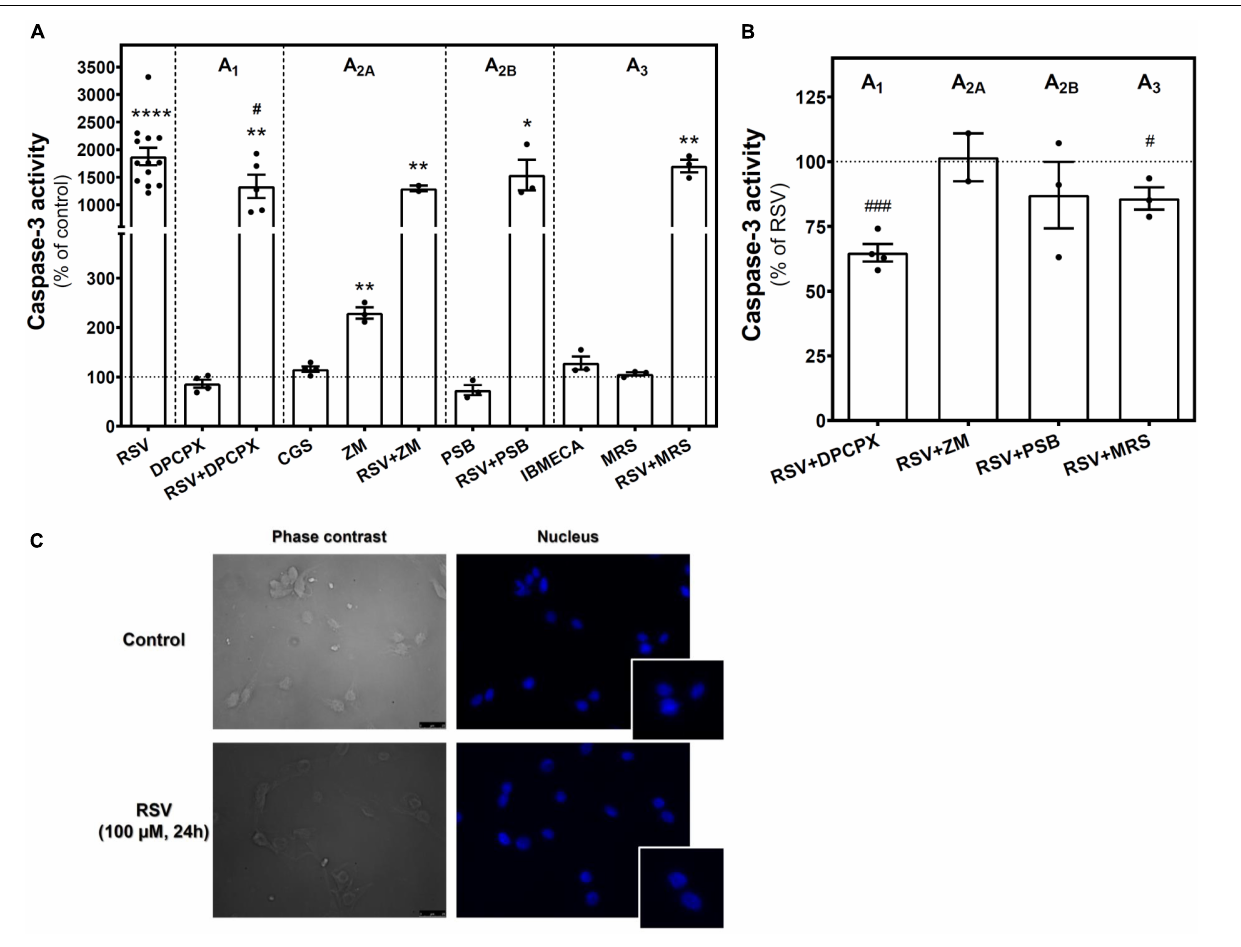
FIGURE 3 | Caspase-3 activity in C6 glioma cells. (A) Caspase-3 activity after 24 h of treatment with 100 µ M RSV, 10 µ M DPCPX, 10 µ M CGS, 100 µ M ZM, 100 µ M PSB, 10 µ M IBMECA, and 10 µ M MRS alone or in combination with RSV. (B) Effect of adenosine receptor antagonists on the activation of caspase-3 elicited by RSV. (C) Absence of apoptotic bodies in control and RSV-treated conditions after Hoechst staining of nucleus. Data are means ± SEM of 3–17 independent experiments. * p < 0.05, ** p < 0.01 and **** p < 0.0001 significantly different from control condition according to Student’s t -test. # p < 0.05 and ### p < 0.001 significantly different from RSV condition. RSV, resveratrol; DPCPX, 8-Cyclopentyl-1,3-dipropylxanthine; CGS, CGS21680; IBMECA, 2-Cl-IB-MECA; MRS, MRS1220; PSB, PSB1115; ZM,